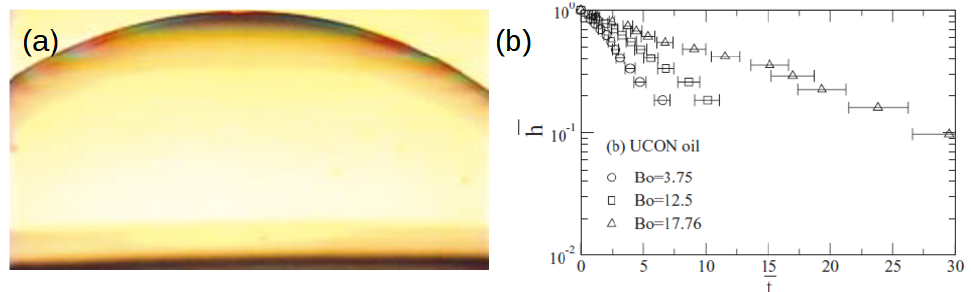
Figure 3. ( a ) View of a large bubble at the surface silicon oil, extracted with authorization from Debregeas et al. [33], ( b ) Normalized film thickness ¯ h = h / h 0 as a function of normalized time ¯ t = t / τ g for different bubble sizes at the surface of Ucon Oil for different Bo B numbers corresponding to different buble sizes, extracted with authorization from Kocarkova et al.